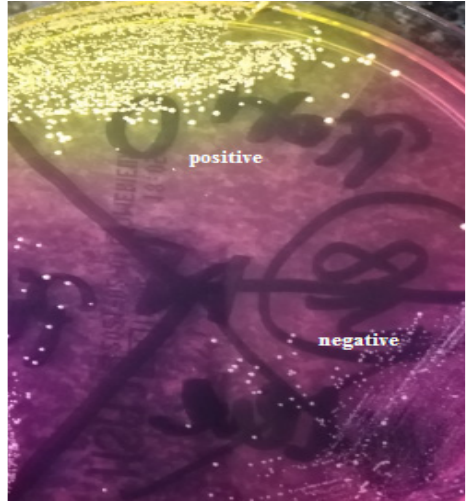
Figure 1. Mannitol salt agar culture result.